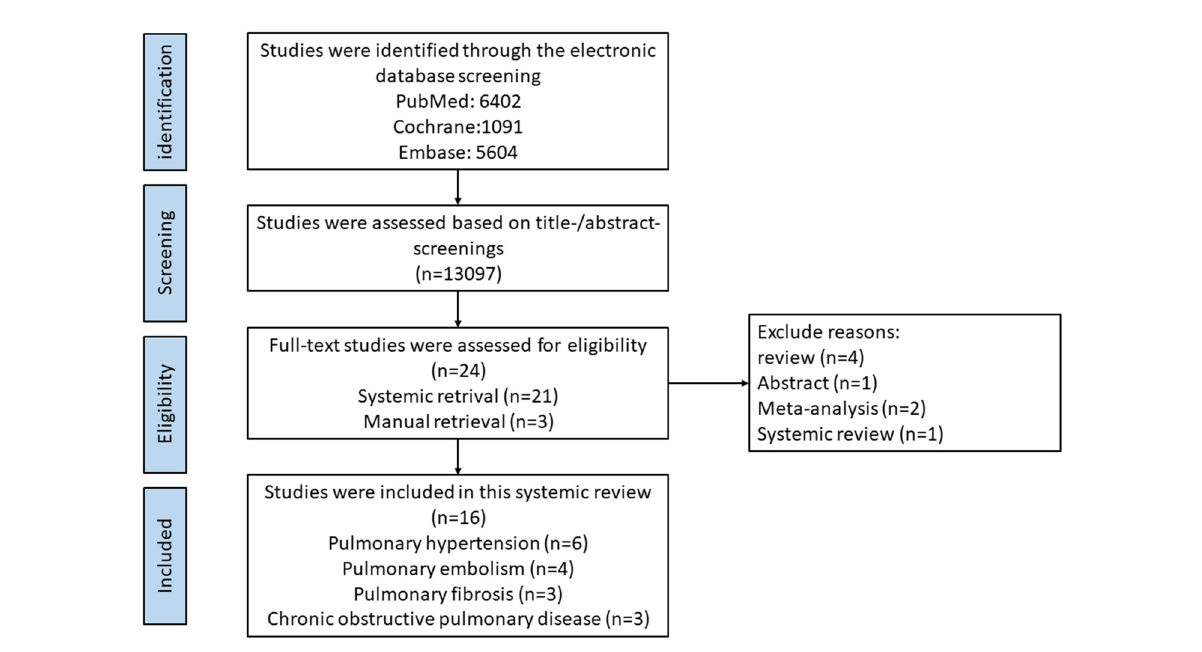
FIGURE1 Flow diagram of literature retrieval process of our systemic